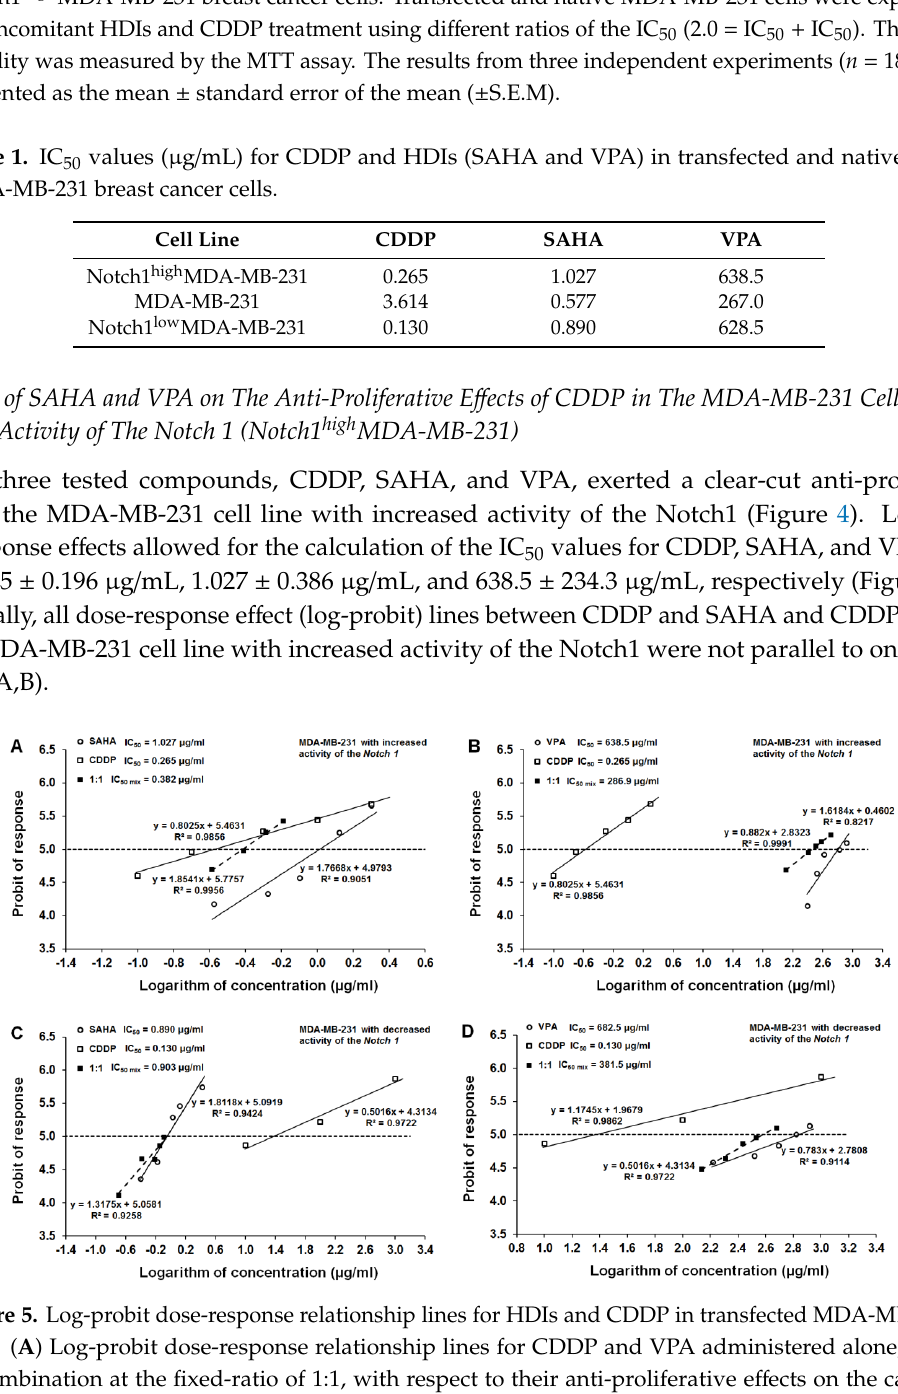
fixed-ratio of 1:1, with respect to their anti-proliferative e ff ects on the cancer cell lines MDA-MB-231 with increased activity of Notch1 (Notch1 high